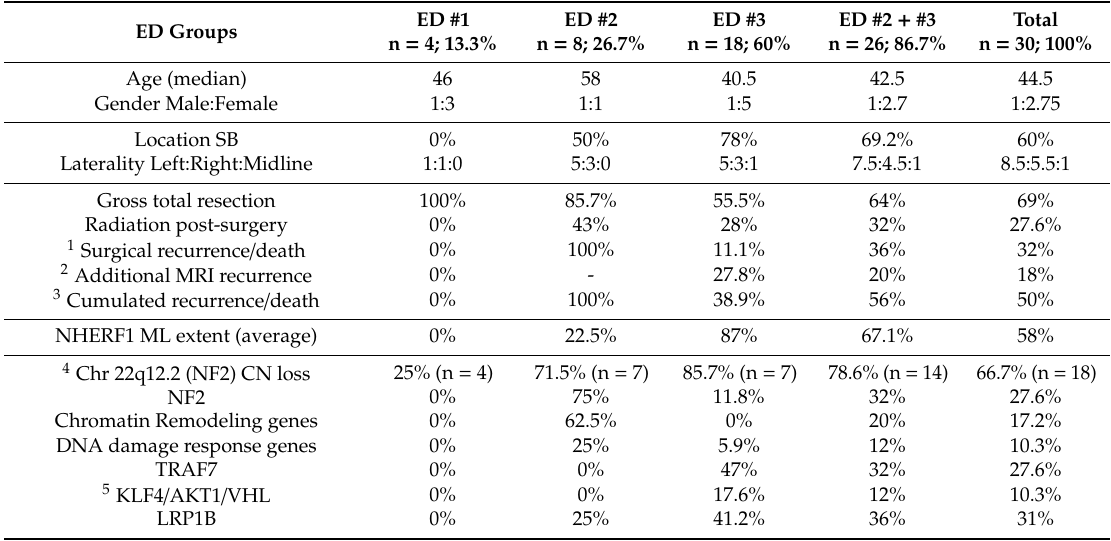
Table 1. Chordoid meningioma: demographic, clinical, histologic and genomic